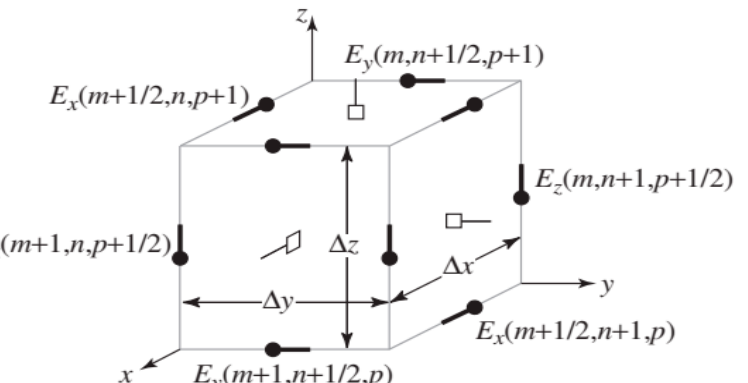
Figure 1. Nodes in a 3D FDTD mesh as a Yee cell. In this image, not all nodes have the same indexes. As shown here, the cube will consist of four E x nodes, four E y nodes, and four E z nodes, i.e., the electric fields are located along the edges of the cube. The magnetic fields are on the faces of the cube and hence there will be two H x nodes, two H y nodes, and two H z nodes.